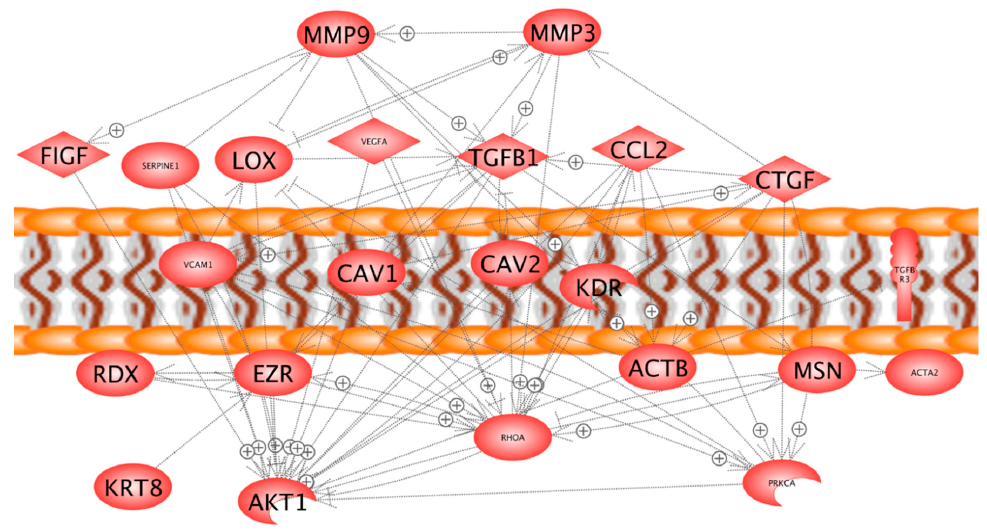
Figure 7. Mutual regulation network at protein level and cellular localization of identified proteins.